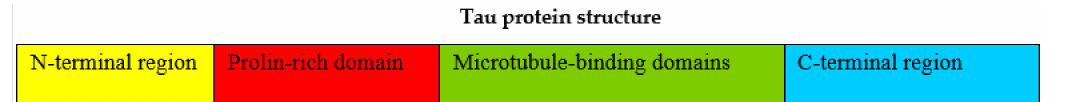
Figure 1. Structure of tau protein: N-terminal region, prolin-rich domain, microtubule-binding domains and C-terminal region. 1–441 number of amino acids. Table 1. Di ff erent patterns of tau protein phosphorylation in post-ischemic brain. Animal or Human Region of Brain